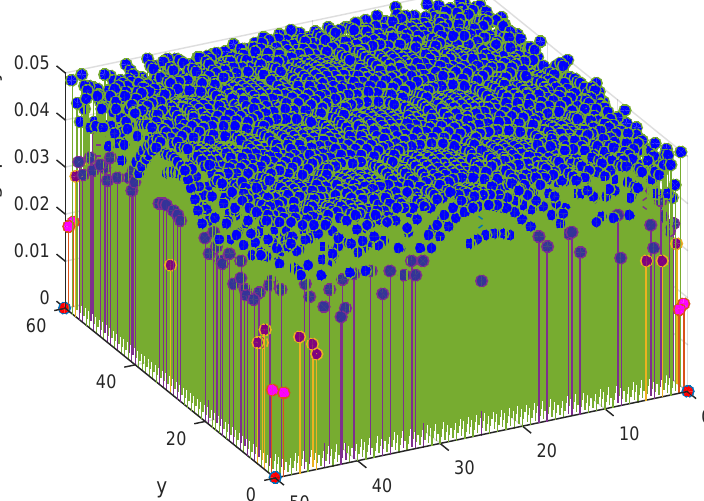
Figure 11. Non-CP for CI ER,5% (0..60, 0..50, 60, 50). To be more precise, over 87% of the cases in the x , y , m = 60, n = 50 group of binomial experiment configurations depicted in Figure 11 have actual non-coverage probabilities in the [4.5%, 5.0%] range and about 95% of the cases have actual non-coverage probabilities in the [4.0%, 5.0%] range (2955 out of 3111 to be exact, the blue bullets in Figure 11).